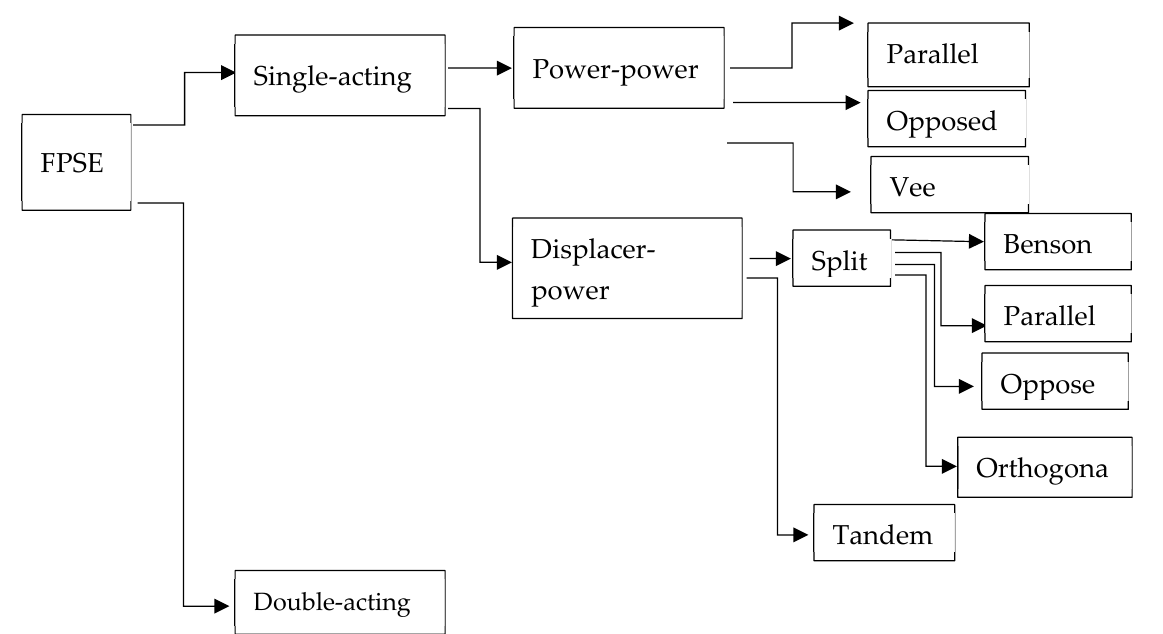
Figure 2. Classification of single-acting and double-acting FPSEs.